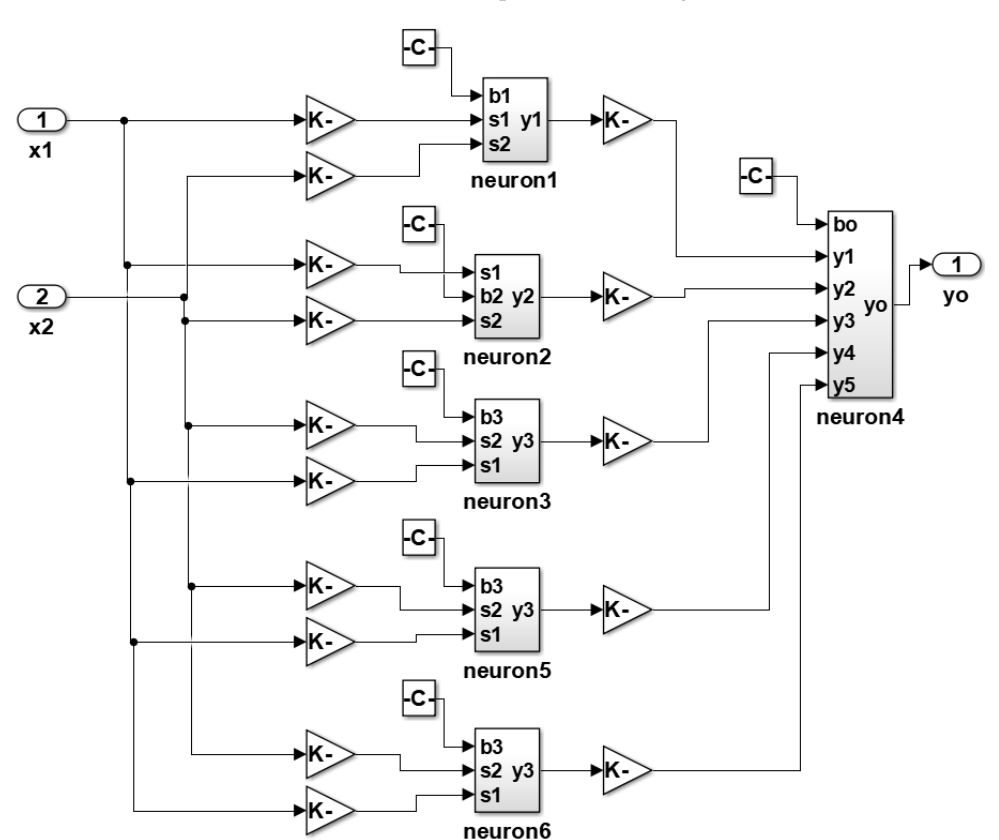
Figure 6. The Simulink model of the trained neural network (NN). Table 3. The measurement results.